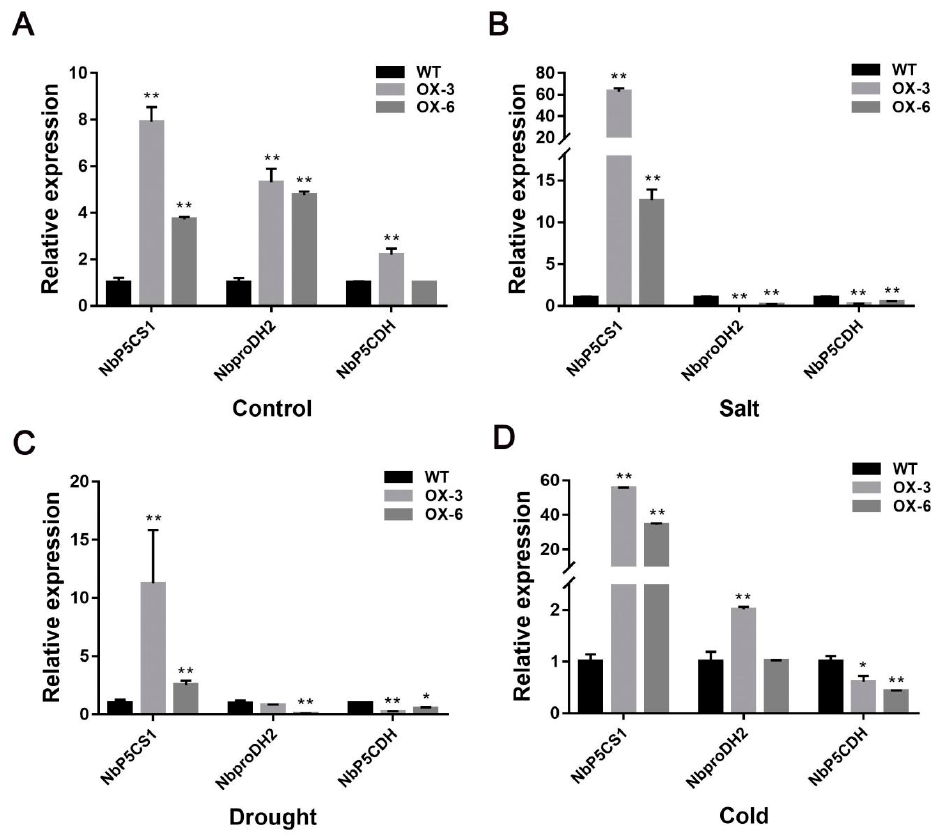
Figure 7. The qRT-PCR analysis of several genes related to proline matabolism in 35S::FaNAC2 lines and WT under different abiotic stress treatments. ( A ) Expression of genes in 35S::FaNAC2 lines and WT under control conditions. ( B ) Expression of genes in 35S::FaNAC2 lines and WT under salt stress. ( C ) Expression of genes in 35S::FaNAC2 lines and WT under drought stress. ( D ) Expression of genes in 35S::FaNAC2 lines and WT under cold stress. Bars are means (±S.D.) of three biological replicantes experiments (Student’s t -test; * p < 0.05; ** p <